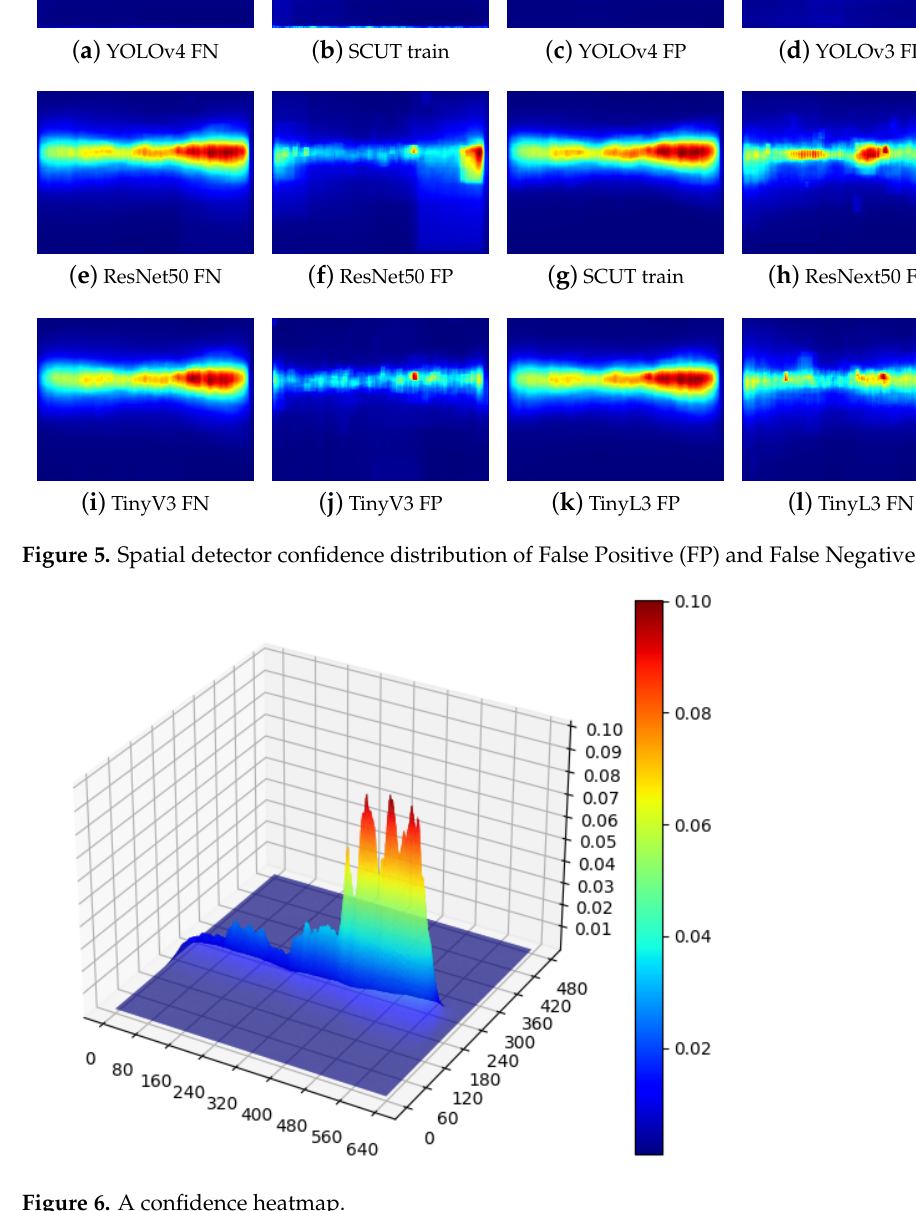
Figure 6. A confidence